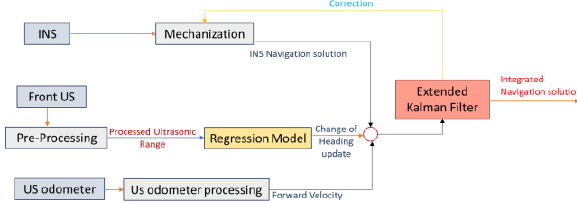
Figure 18. INS/Ultrasonic system integration scheme during GNSS signal